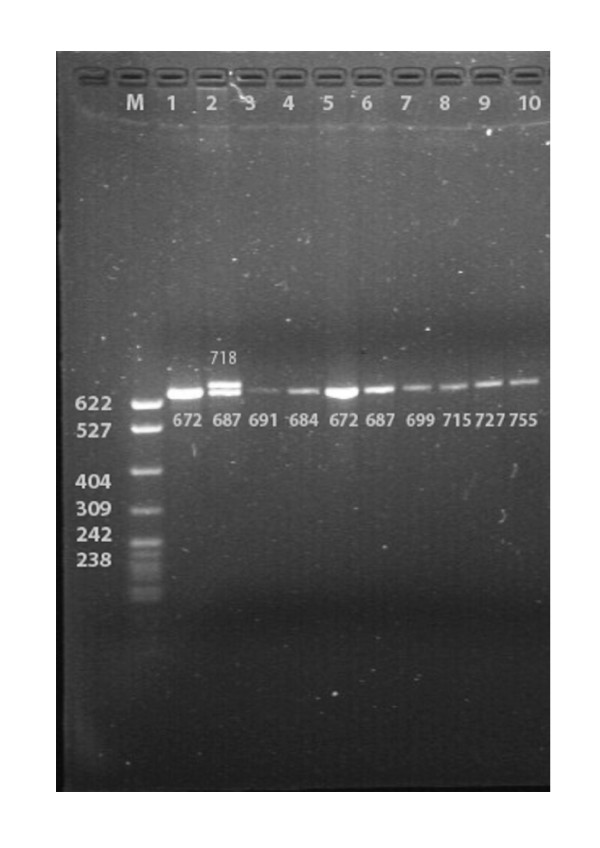
Electrophoretic result of PCR products of the samples in Han. Lane M, 322 bp marker ladder (PBR322/MspI); Lane 2, heterozygote (two straps); Lanes 1, 3–10, homozygotes (one strap)